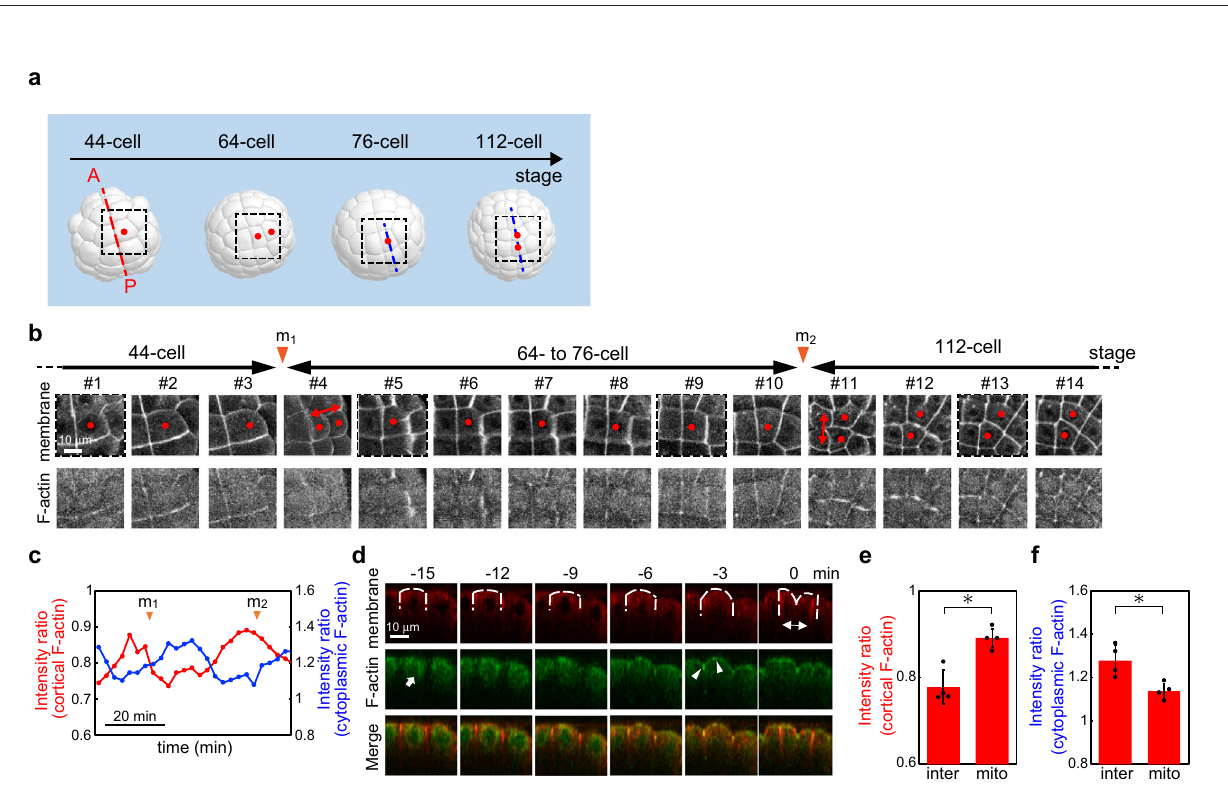
Fig. 3 Mapping the ascidian embryo in the animal hemisphere. a Morphological change in animal cells of the 3D model from the 32-cell to the 112-cell stage. Dotted line (red) represents the anterior – posterior line of the embryo. Four dotted squares (black) represent measured regions that approximately correspond to the four images (#1, #4, #7 and #12) in b . b Portions of the H and E images of the embryo mapped in the animal hemisphere from the 44-cell to 112-cell stage, where cells indicated by dots (red) were tracked. The cell division was observed at times depicted by the arrowheads (orange: m 1 and m 2 ). Double-headed arrows (red) represent the direction of cell division. c Plots of geometrically averaged E around the centre of cells depicted by the dots (red) in b . d E- values of embryonic cells at the timing of cell division (mito) and in interphase (inter). Data are geometric mean ±s.d. from n = 6 embryos. ** P < 0.01. e Schematic of the change in E of animal cells from the 32-cell to the 112-cell stage. The E -value of embryonic cells in the 3D model measured by AFM was coloured with a greyscale, showing that the single-cell stiffness increased at the timing of cell division (m 1 and m 2 ) without any apparent cell-to-cell heterogeneities. Cells (light blue) in the 3D model represent those that were not probed by AFM. f Portions of the H and E images of the embryo mapped in the animal hemisphere from the 32-cell to 112-cell stage treated with Y-27632 at 64-cell stage as depicted by the arrowhead (black) where cells depicted as dots (red) were tracked. The dotted square (black) in the 3D embryo model represents the region of the fi rst image (#1). The cell division occurred at times depicted by arrowheads (orange: m 1 and m 2 ). Double-headed arrows represent the direction of cell division. g Plots of geometrically averaged E around the centre of cells depicted by the dots (red) in f . The addition of Y-27632 is depicted by the arrowhead (black). h E -values of Y-27632-treated cells at the timing of cell division (mito) and in interphase (inter). Data are geometric mean ±s.d. from n = 4 embryos. * P < 0.05.